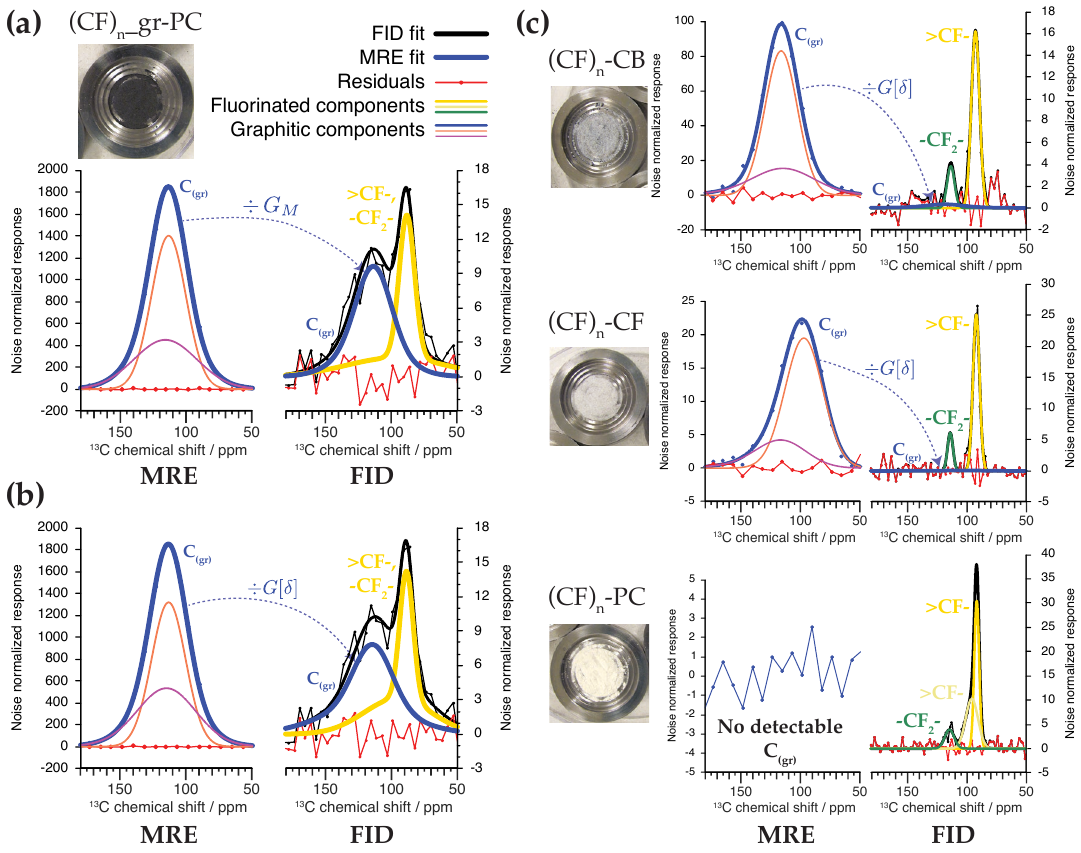
Figure 4. Quantification of graphitic 13 C MAS NMR signals by downscaling the noise normalized ( σ ( N ) = σ ( N ) = 1 ) matched reconstructed echo onto the FID. ( a ) Scaling of the MRE onto the FID of 0 W (CF) n _gr-PC using a fixed gain of G M = 192.2. ( b ) Scaling of the MRE using a chemical shift dependent gain function G [ δ ] determined from analysis of differential T CPMG relaxation. ( c ) Comparison of the FID and MRE signals for the fully fluorinated (CF) n